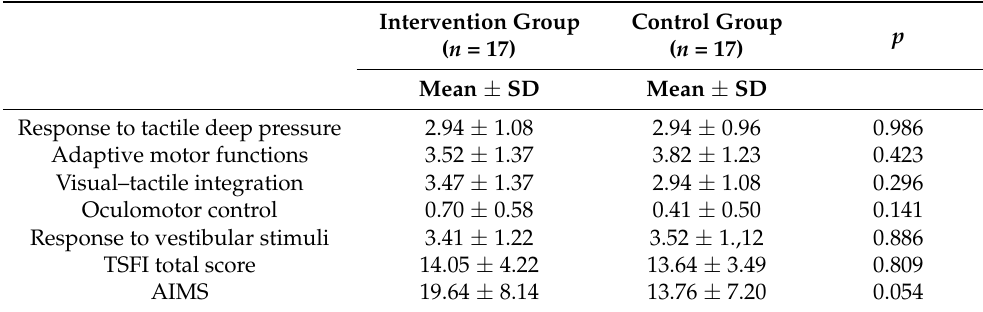
Table 2. Comparison of Pre-Treatment Scores in the Test of Sensory Functions in Infants and the Albert Infant Motor Scale.